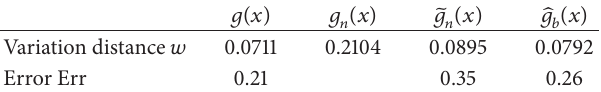
Table 3: 𝑤 and Err measures with different